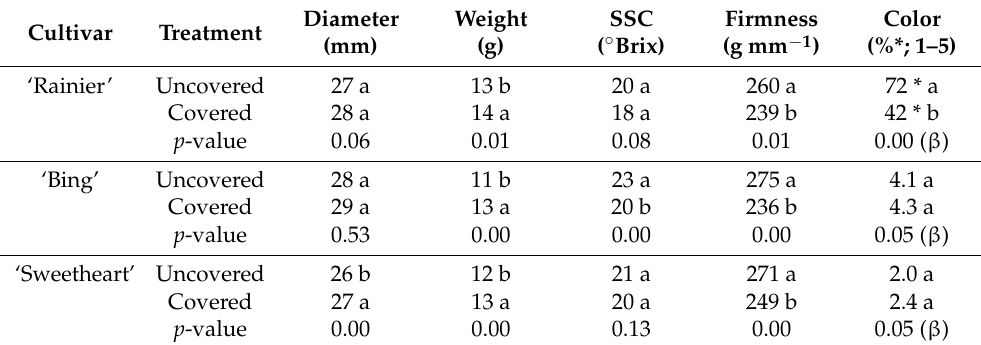
Table 6. Quality parameters of ‘Rainier’, ‘Bing’ and ‘Sweetheart’ sweet cherries with and without rain cover. Cultivar